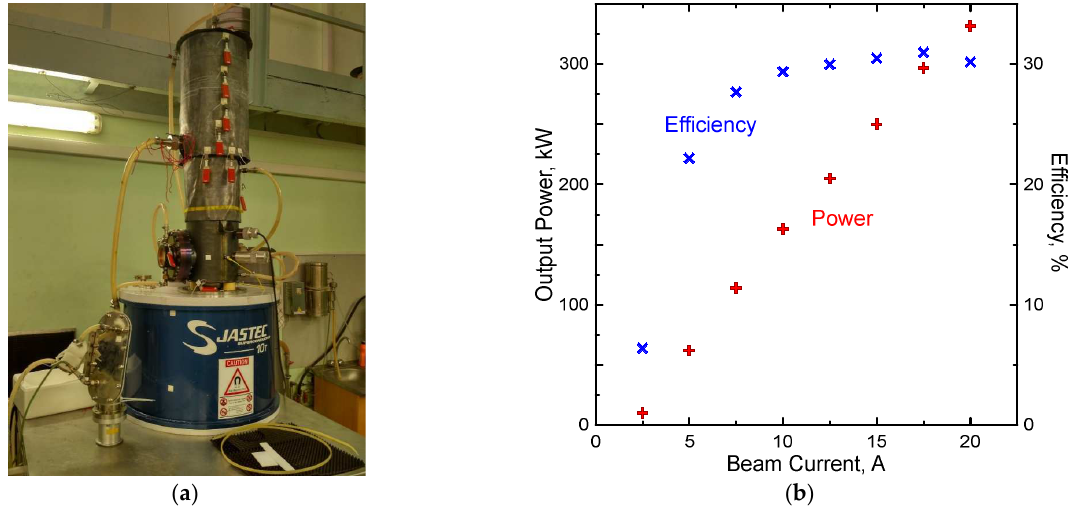
Figure 1. ( a ) General view of the 250 GHz gyrotron with TE 19,8 operating mode. ( b ) Experimentally obtained dependence of the output power and efficiency on the value of the beam current.